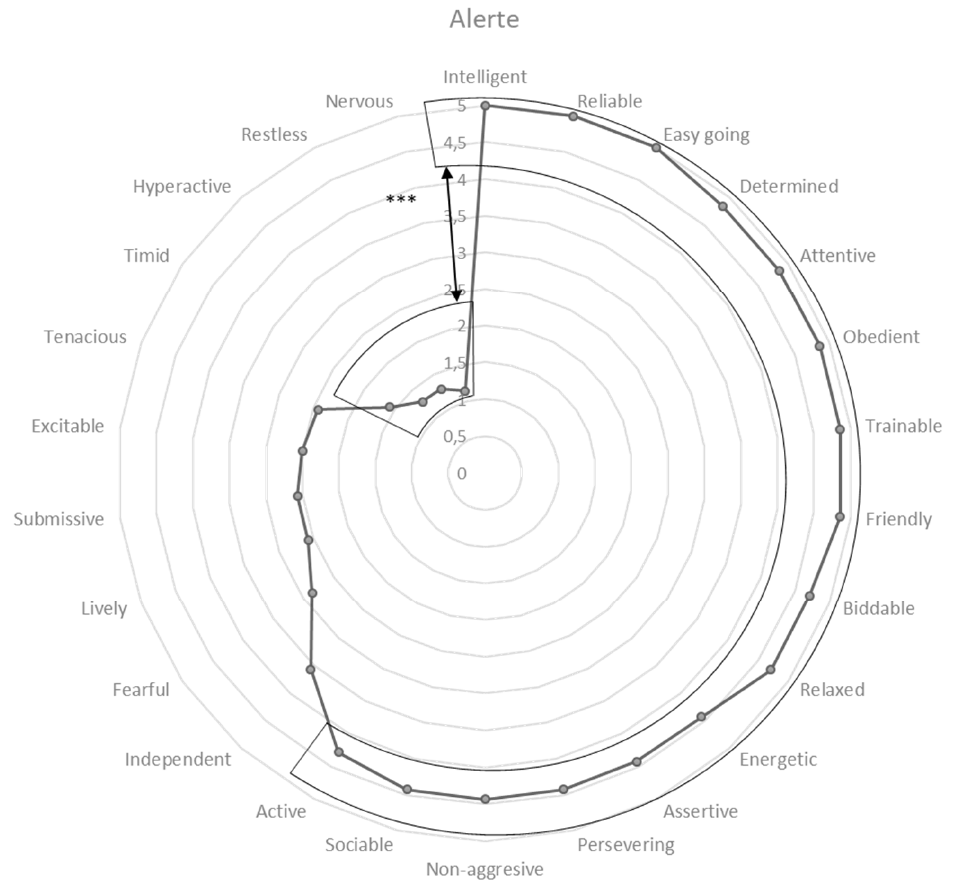
Figure 2. Behavioral profile of seizure-alert dogs. Score differences between behavioral items for seizure-alert dogs were assessed with a Kruskall–Wallis test, *** <0.0001.